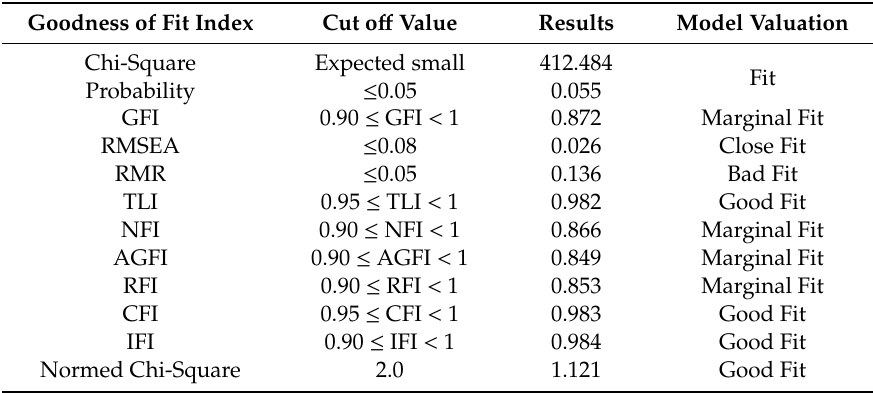
Table 1. Assessment of the goodness of fit research model.